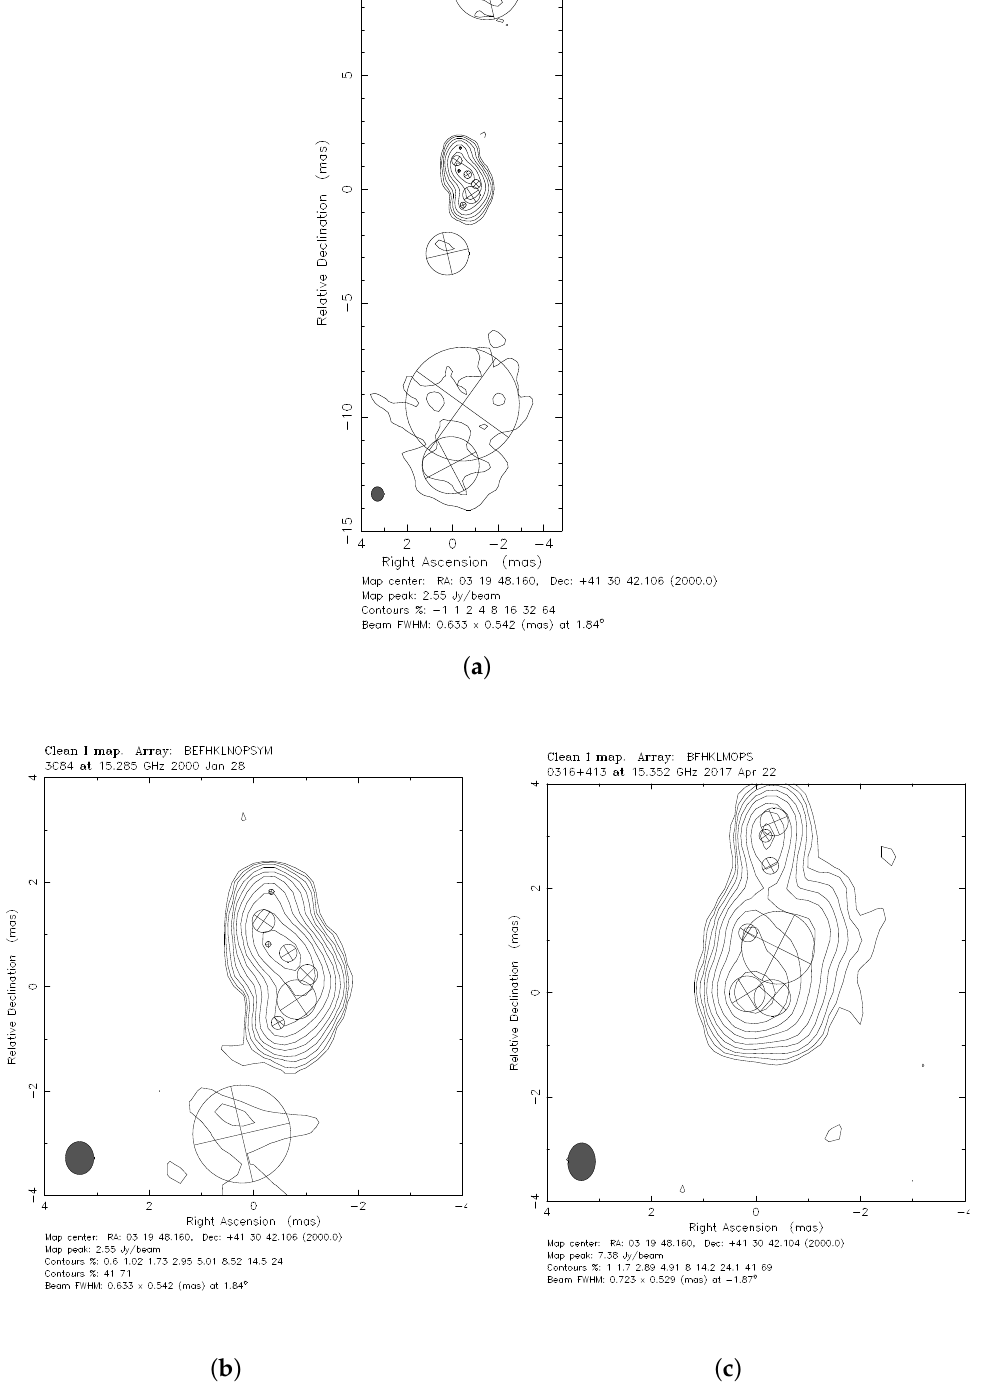
Figure 2. ( a ) A map of 3C 84 with the Gaussian components superimposed showing the structure in 15 GHz VLBA observations (January 2000). ( b ) a map of the central region of 3C 84 with the Gaussian components superimposed ((January 2000). ( c ) 17 yr later the same central region is not one chain of components any more but the overall structure is broader as the morphology has evolved (April